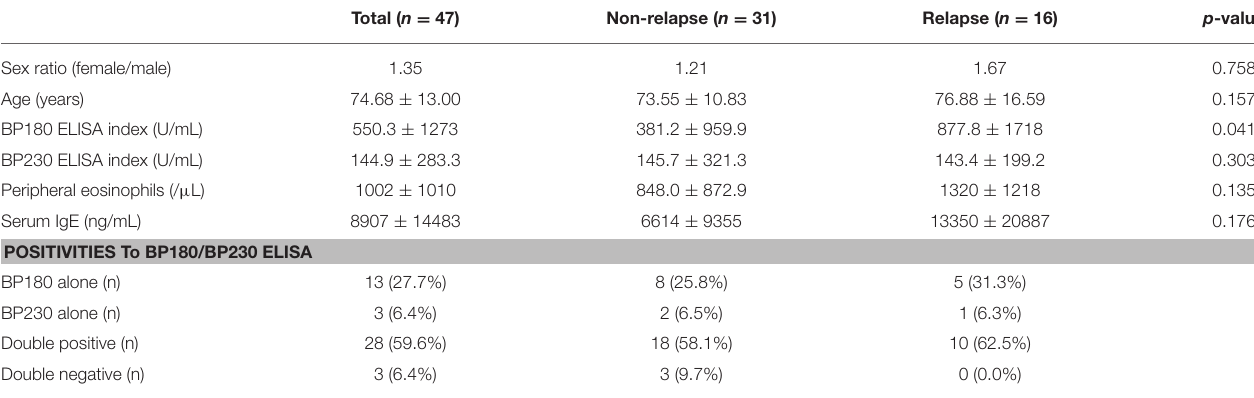
TABLE 1 | Characteristics of BP patients at baseline.